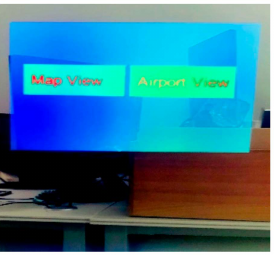
Figure 5. Holographic menu to change the view of air tra ffi c.